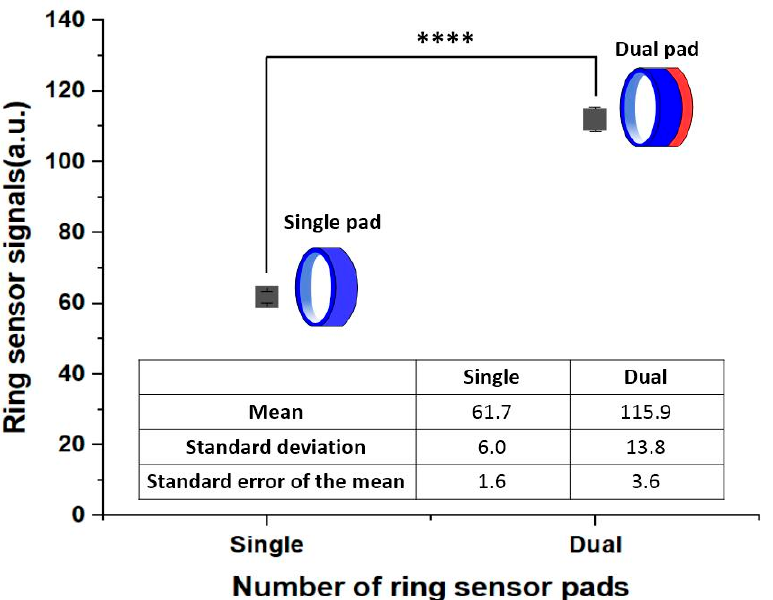
Figure 4. Experimental results for the ring sensor signals according to the number of sensor pads ( n = 15). The sensor’s signal strength of the dual pad was almost twice that of the single pad. Asterisks are denoting the statistical significance, ranging from significant (*) to extremely significant (****).